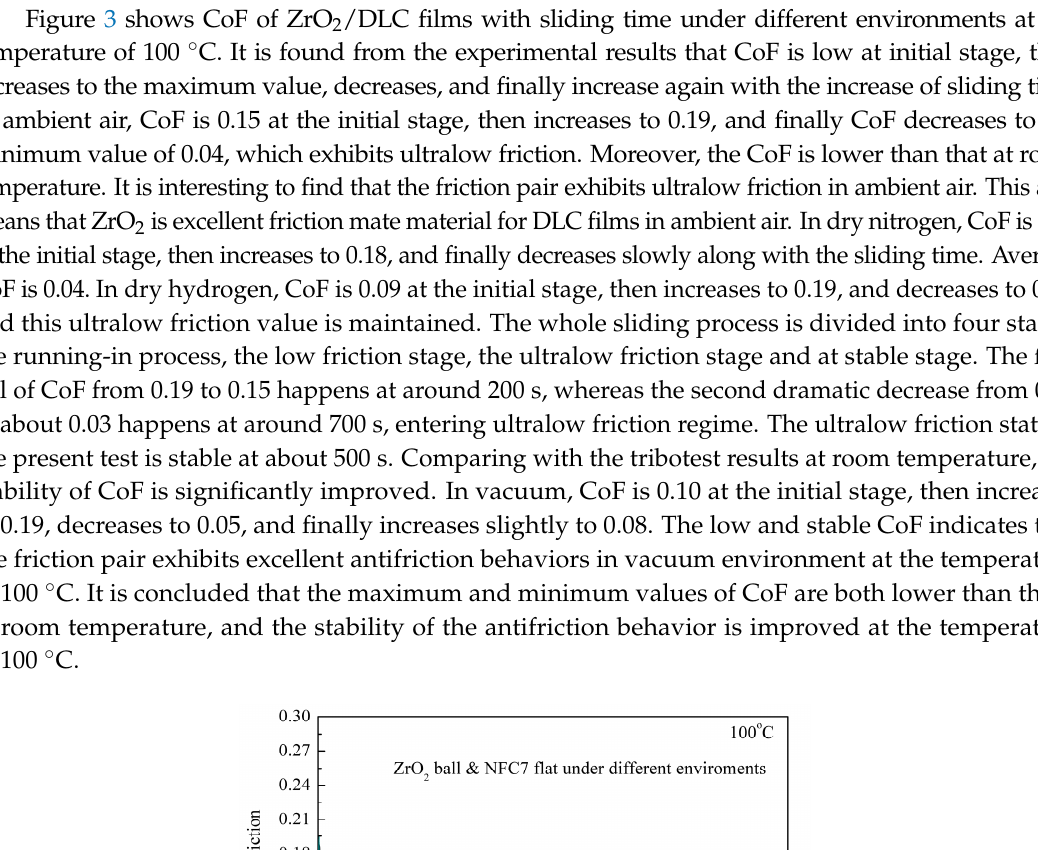
Figure 3. CoF of ZrO 2 ball/DLC films under different environments at 100 °C.